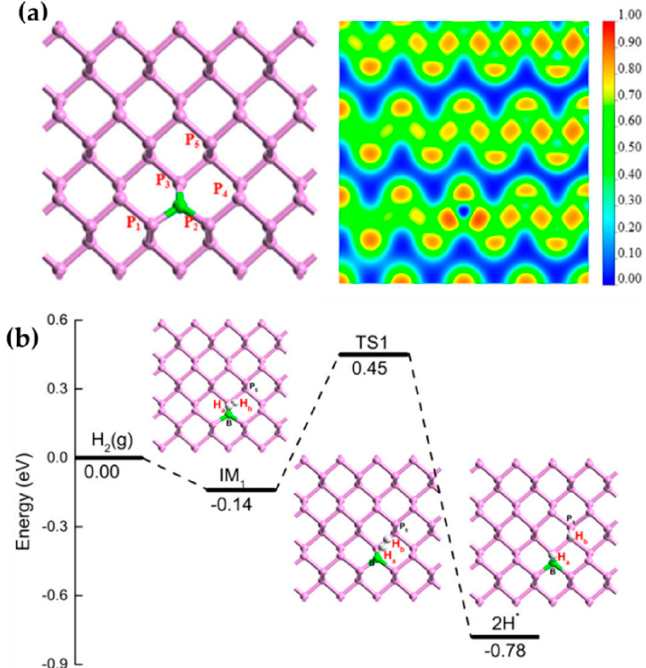
Figure 9. ( a ) Structure and electron localized function (ELF) diagram of B doped phosphorene. ( b ) Energy diagram of H 2 activation catalyzed by B doped phosphorene, symbol * indicated adsorption site here. Adapted from reference [54] with permission.